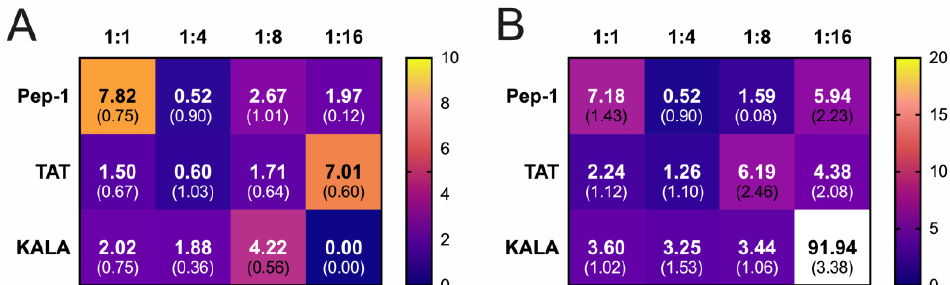
Figure 3. Effect of 24 h culture in the presence of complexes in CRs of 1:1, 1:4, 1:8 and 1:16. The complexes were formed using incubation of 1 μ g pmaxGFP with chosen CPPs at 21 °C for 15 min. CR, charge ratio. ( A ) Transfection efficiency. ( B ) Percent of cells with abnormal morphology. Data are presented as means, numbers in parentheses represent standard deviations.